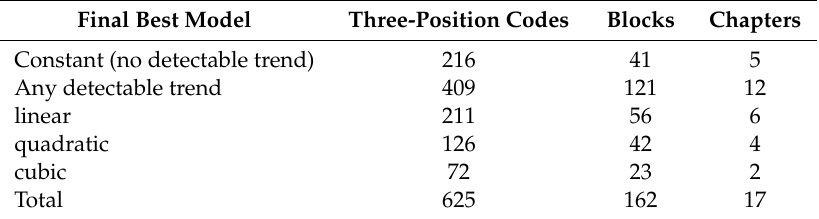
Table 2. Distribution of the final best model of ICD-10 Causes of Death at di ff erent levels of